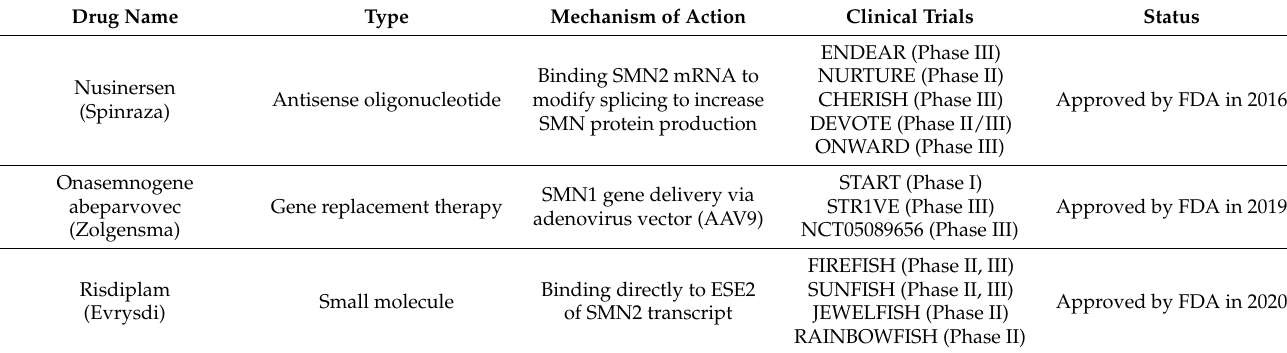
Table 1. Comparison of approved drugs for SMA